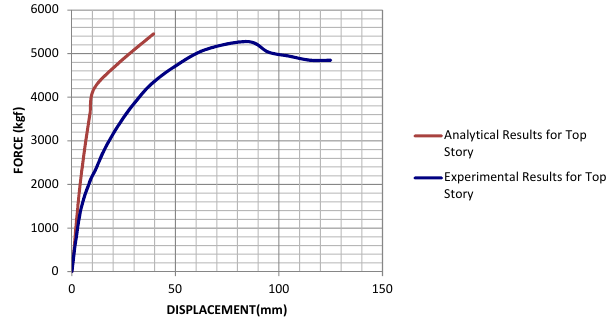
Fig. 9. Retrofitted specimen experimental and analytical force– displacement curve for top storey.